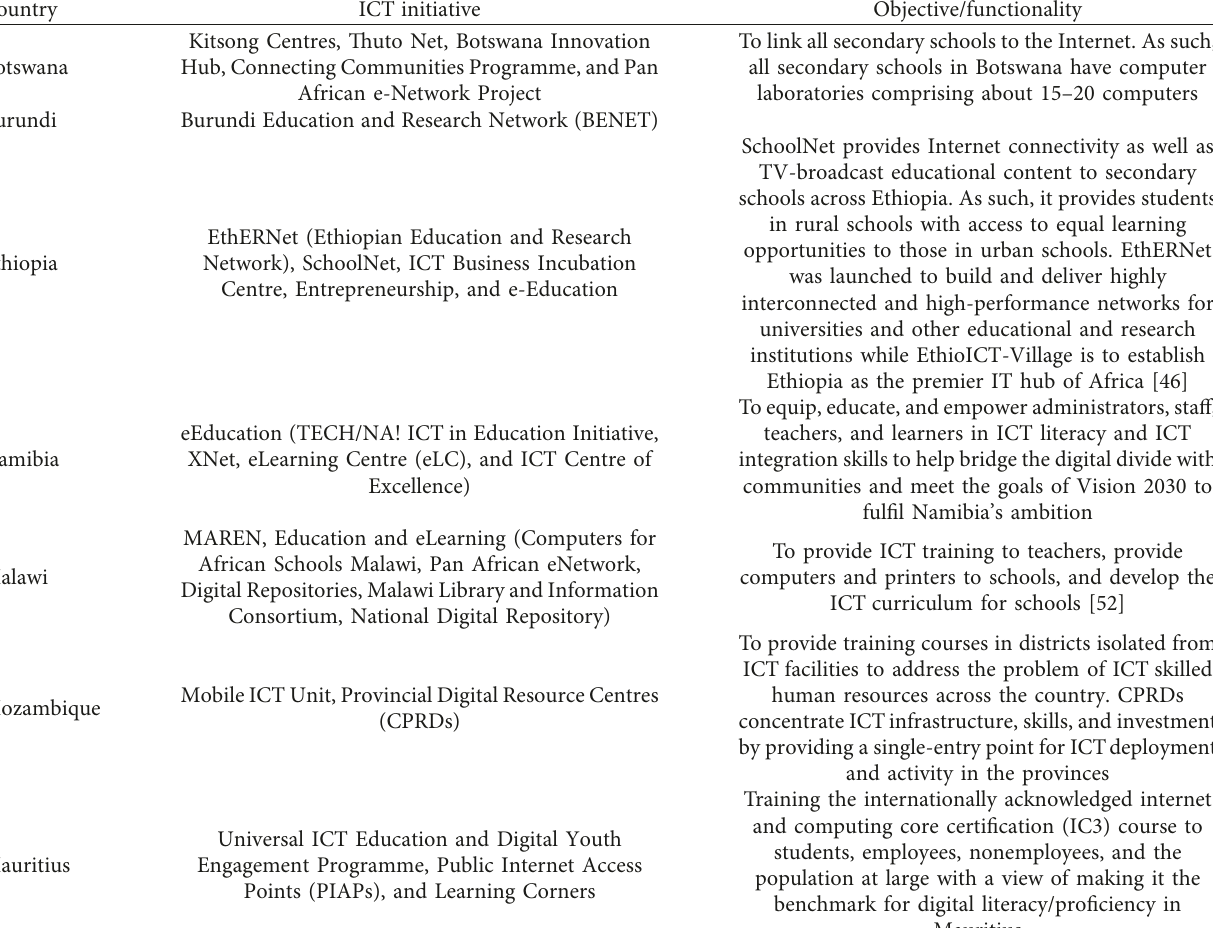
Table 1: A summary of ICT in education platforms, projects, and implementations in southern African countries.